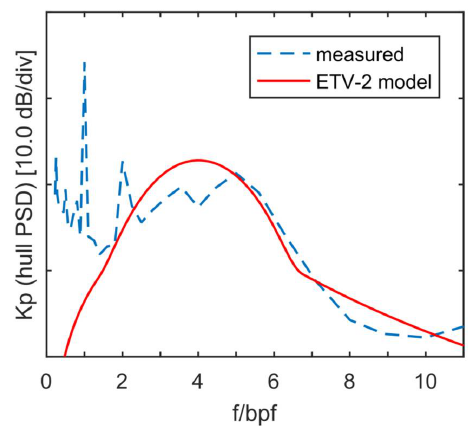
Figure 13. Example of the measured and predicted non-dimensional hull pressure spectrum for a ship propeller of the database tested at full scale.